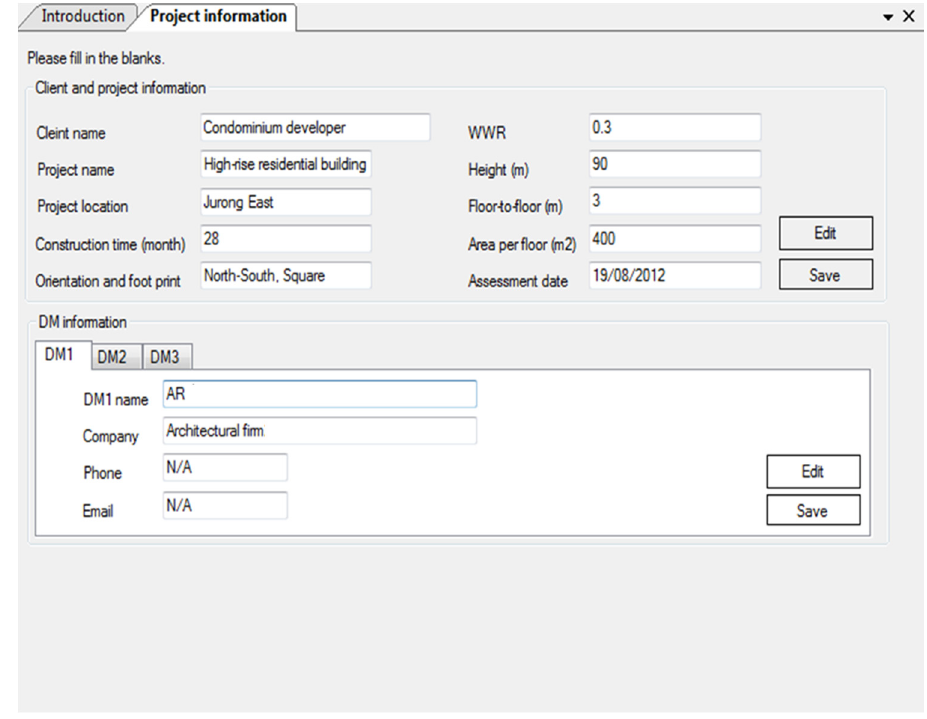
Figure 3. Project information.